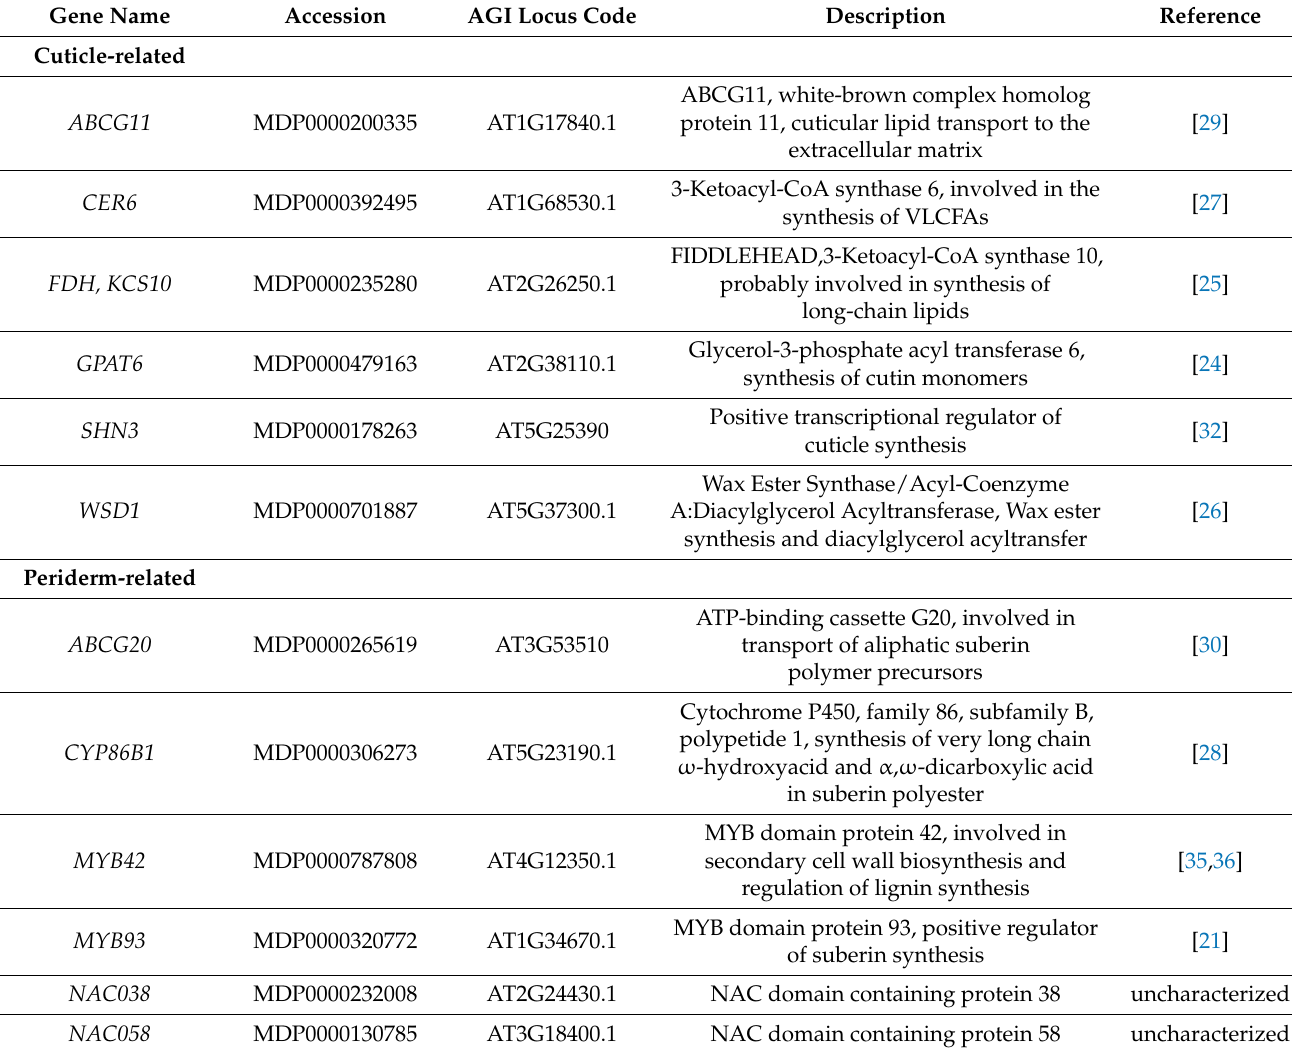
Table 1. List of genes analyzed in the gene expression